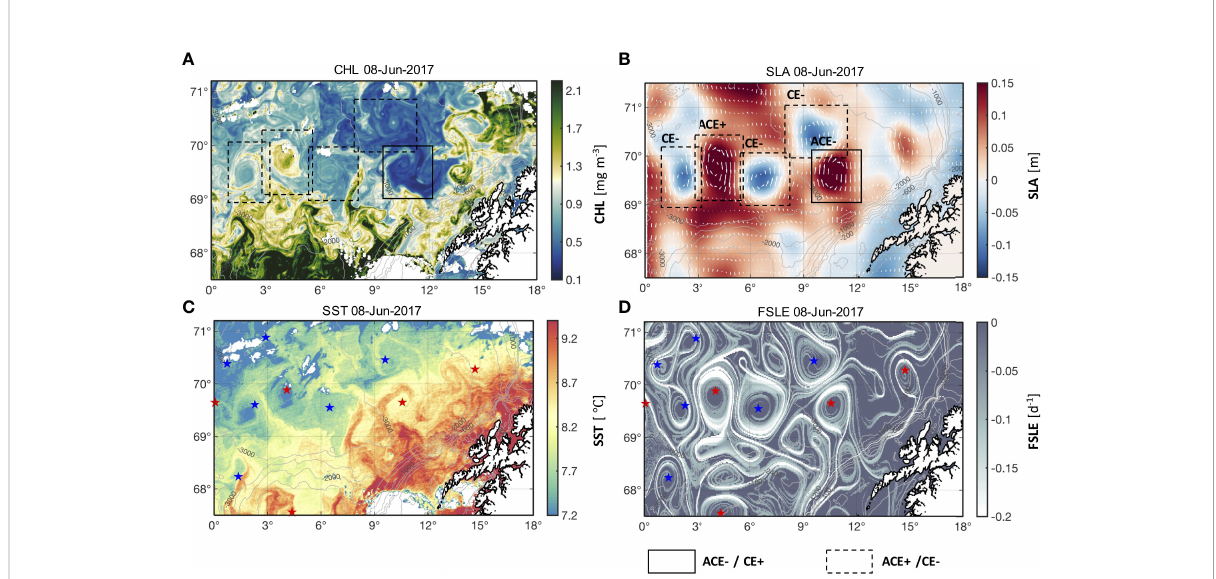
FIGURE 4 Spatial distribution of (A) CHL, (B) SLA, (C) sea surface temperature (SST), and (D) Finite-size Lyapunov Exponent (FSLE) for 8 June 2017. ACE- and CE+ in (A, B) are demarcated by solid boxes; ACE+ and CE- in (A, B) are demarcated by dashed boxes. ACEs and CEs in (C, D) are indicated by red and blue